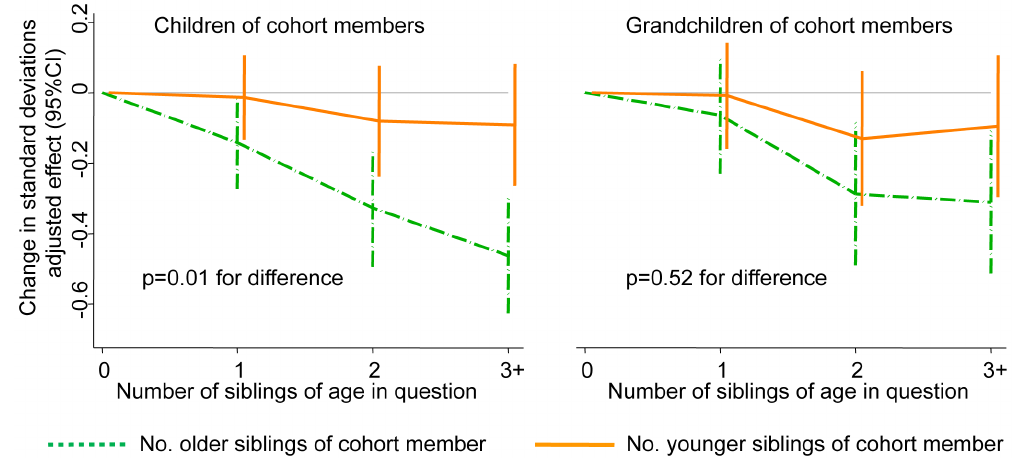
Figure 4. Association of the cohort members’ number of older versus younger siblings with the probability of entering university among their children and grandchildren. p-values presented are for the difference in the effect of the cohort members’ number of older versus younger siblings, from multivariable models adjusting for both sibling variables plus the other early-life characteristics shown in Table 1.